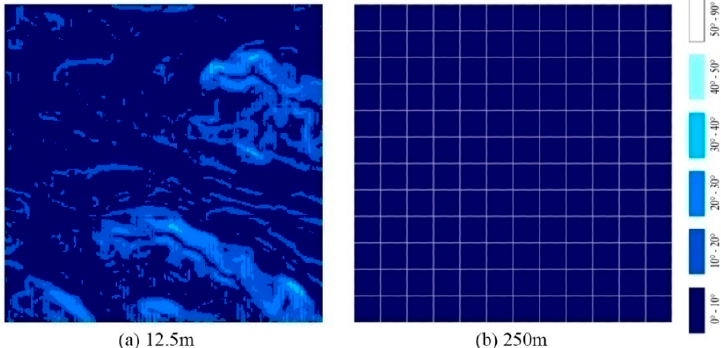
Figure 16. Slope of Saihanba at different scales: ( a ) 12.5 m; ( b ) 250 m.